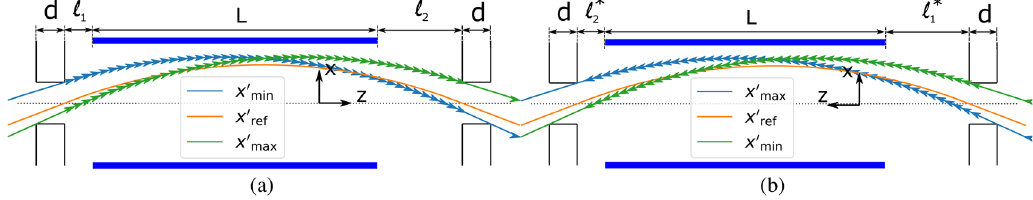
FIG. 15. Reversing particle velocity allows one to check results when the E-dipole placement is asymmetric.